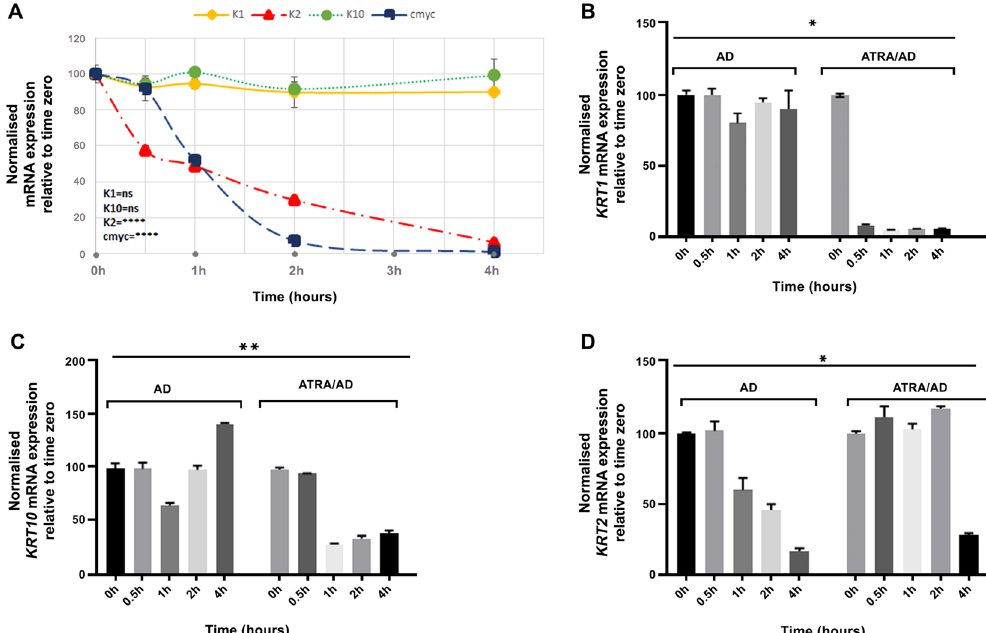
Figure 7. Differential stability of KRT1 , KRT10 , KRT2 and c-MYC mRNA in NHEK. ( A ) NHEK (200,000 cells) mixed with 10 6 irradiated 3T3 fibroblasts were co-cultured in 2 ml RM + medium containing PR per well of a 12 well plate in triplicates for each gene. Cells were treated with 2 µ g/ml AD for up to 4 h, the feeder was removed by squirting PBS/EDTA and the NHEK were lysed for qPCR analysis of KRT1 (yellow diamond), KRT10 (green circle), KRT2 (red triangle) and c-MYC (blue square) gene expression analyses. All data are shown as relative expression normalised to POLR2A and YAP1 , untreated cells were used as zero-time control. NHEK (200,000 cells) mixed with 10 6 irradiated 3T3 feeder cells were grown in CS-FCS containing RM + medium without PR per well in a 12 well plate in triplicates for different time point for each gene. ATRA was added at 1 µ M for 24 h prior to adding AD for up to 4 h after which the 3T3 feeder was removed by squirting PBS/EDTA and qPCR lysates were collected for ( B ) KRT1 , ( C ) KRT1 0 and ( D ) KRT2 gene expression analyses. DMSO/EtOH was used as vehicle control (0.001%/0.01% mixture) for ATRA treated samples. All data are shown as relative expression normalised to DMSO/EtOH control and two reference genes, POLR2A and YAP1 . Statistical analyses: n = 3, Error bars = SEM. Two-way ANOVA (Time, Treatment) was used to calculate p values in ( B – D ), one-way ANOVA in ( A ), p values are given by asterisks (ns = p > 0.05, * p < 0.05, ** p < 0.01 and **** p <